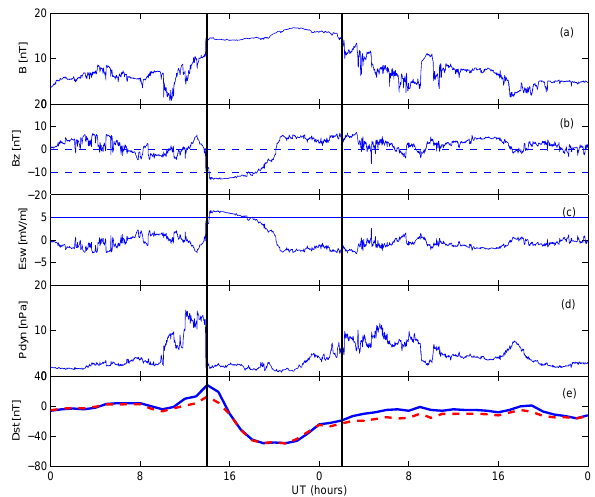
Fig. 9. Solar wind parameters and geomagnetic indices for a 2-day interval from 3–4 August 1997 measured by WIND. The figures from top to bottom show magnetic field strength ( a ) , magnetic field B z -component in the GSM coordinate system ( b ) , solar wind dy- namic pressure ( c ) , solar wind electric field ( d ) and the D st index (solid line) together with the pressure corrected D st (dashed line) ( e ) . Two solid lines indicate the interval of an MC.